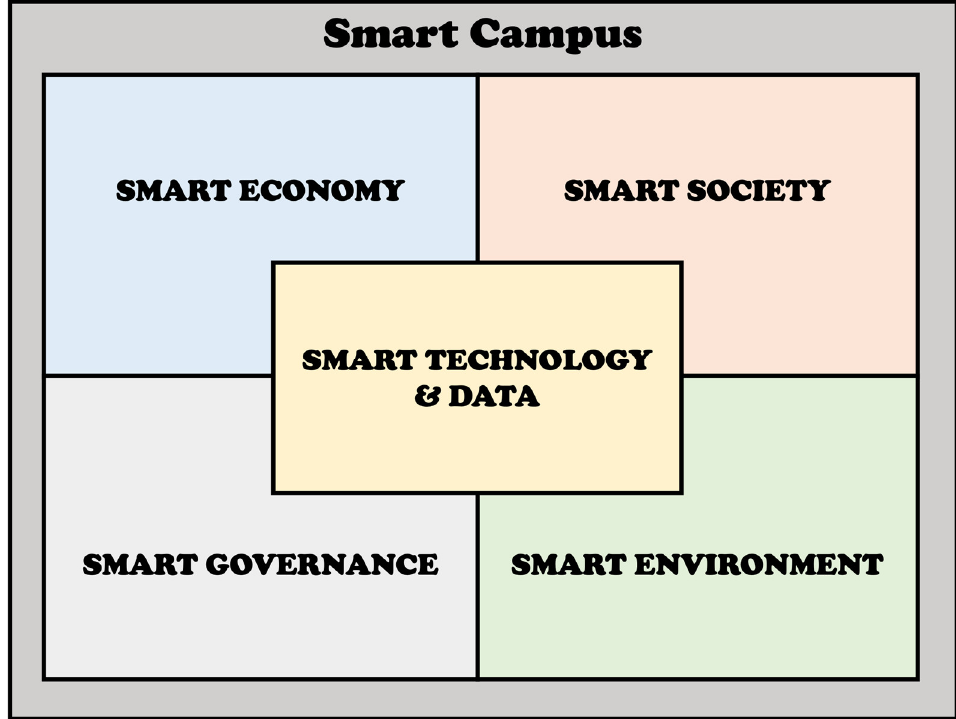
Figure 2. Smart campus domains.